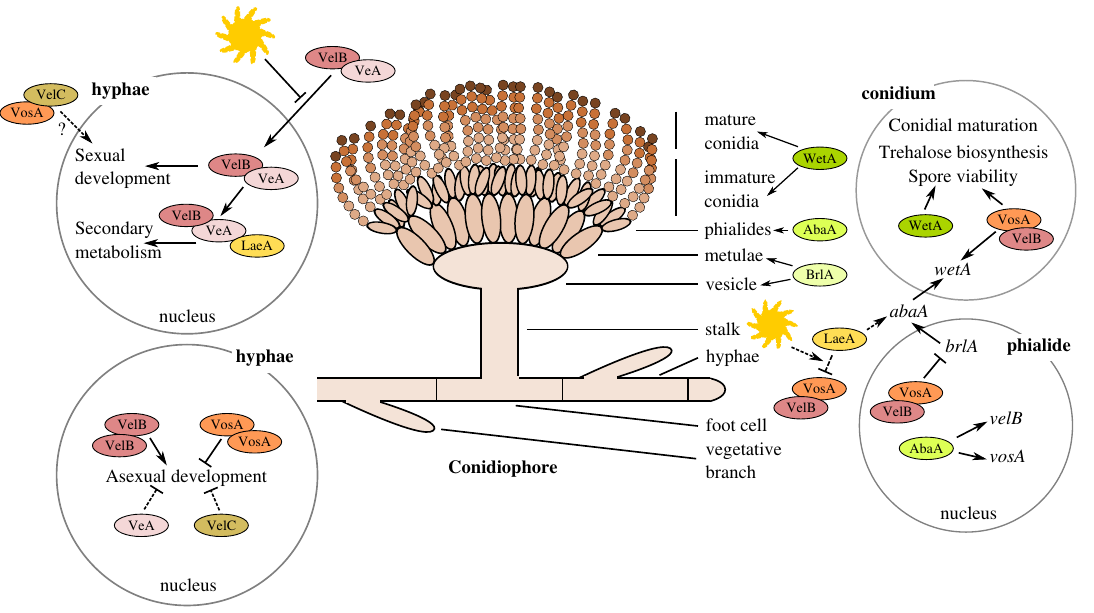
Figure 1. A schematic description of the cellular differentiation of the model fungus A. nidulans with the suggested role of the velvet gene family. Modified and based on Park and Yu (2012) and Sarikaya Bayram et al. (2010)